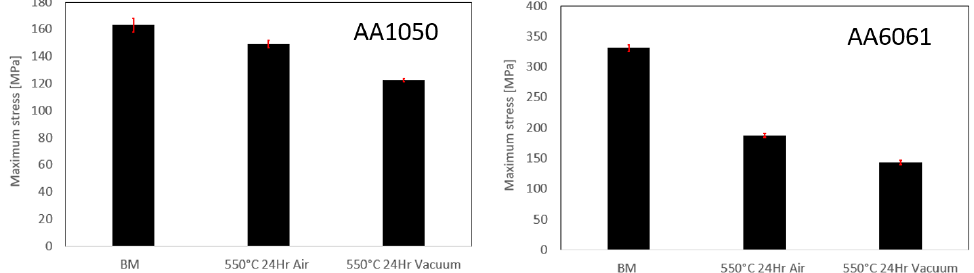
Figure 6. Tensile strength of AA1050 and AA6061 before and after heat treatment for 24 h at 550 °C.